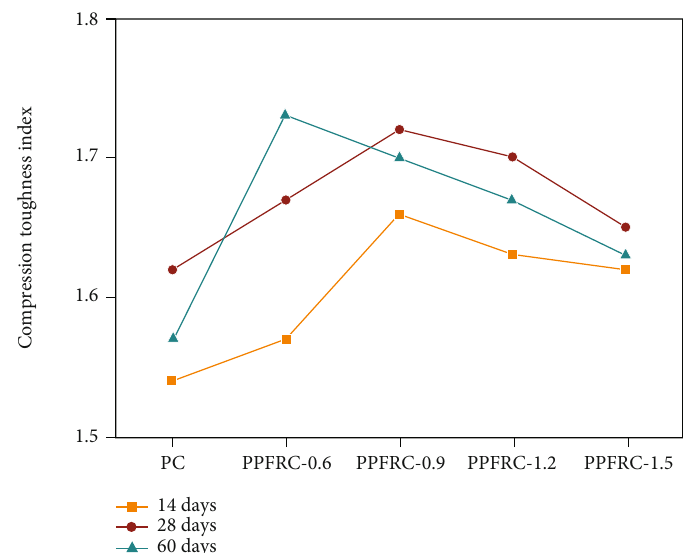
Figure 13: Compressive toughness index at 14, 28, and 60 days of curing.